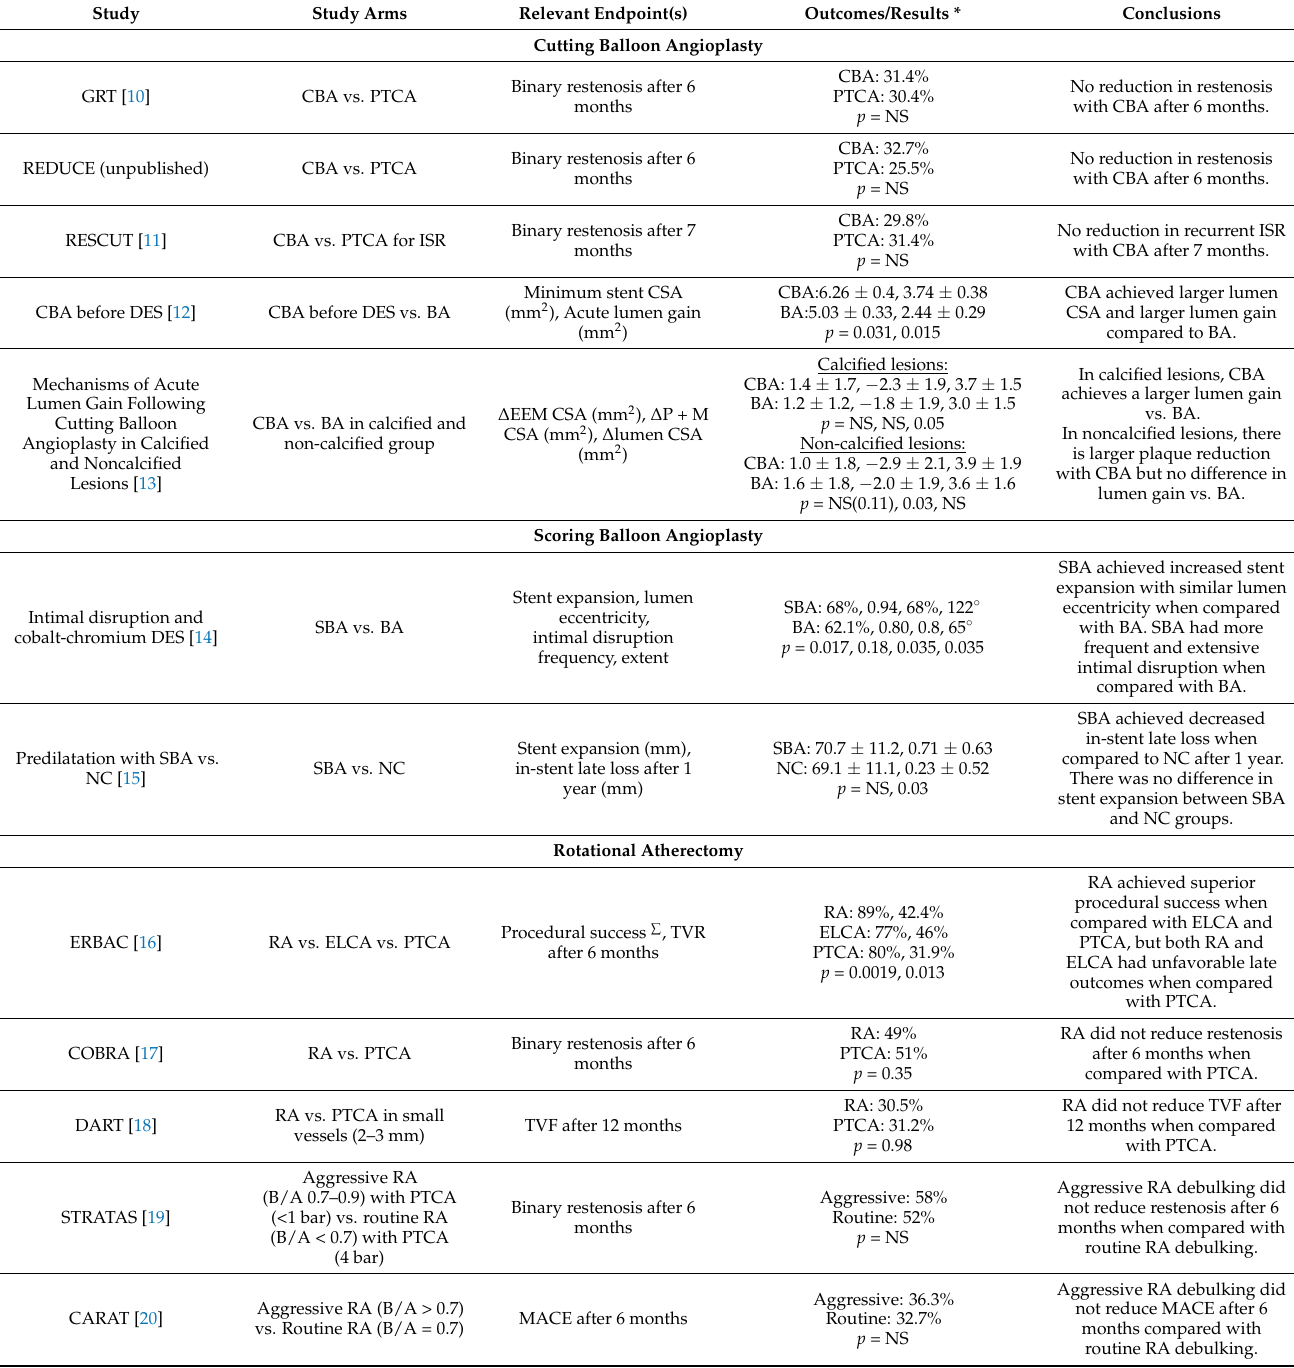
Table 1. Relevant clinical trials for the treatment of coronary